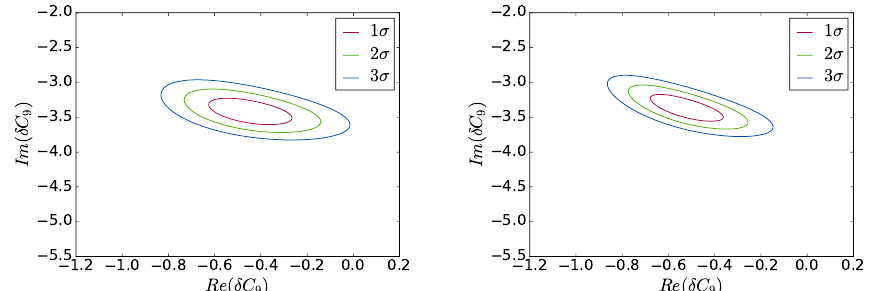
Figure 6 . Projections of the real and imaginary part of (cid:14)C 9 assuming integrated luminosity of 300 fb (cid:0) 1 . Only (cid:14)C 9 is allowed to di(cid:11)er from zero. The contours on the left correspond to (cid:12)ts up to q 2 = 6 GeV 2 , and the contours on the right correspond to (cid:12)ts up to q 2 = 8 GeV 2